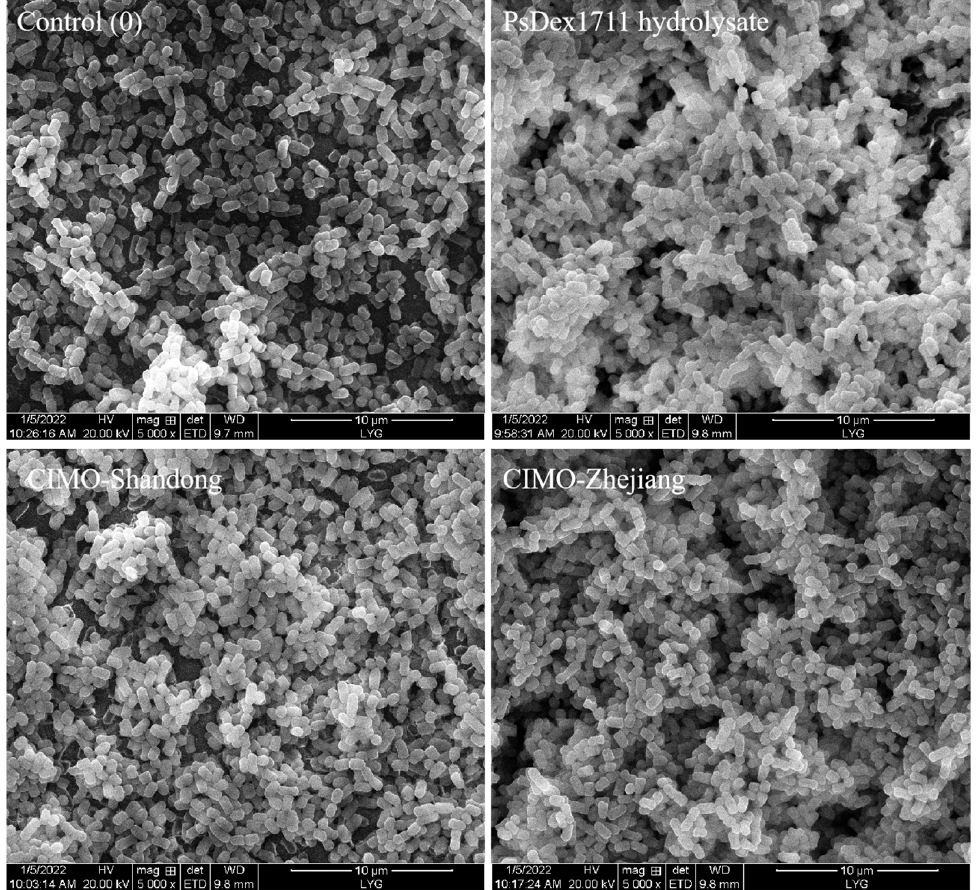
Figure 7. The promoting effect of IMOs on the formation of lactic acid bacteria biofilm was observed through scanning electron microscopy. (5000×, from the left to right with no addition, add the PsDex1711 hydrolysate, add CIMO-S, and add CIMO-Z).